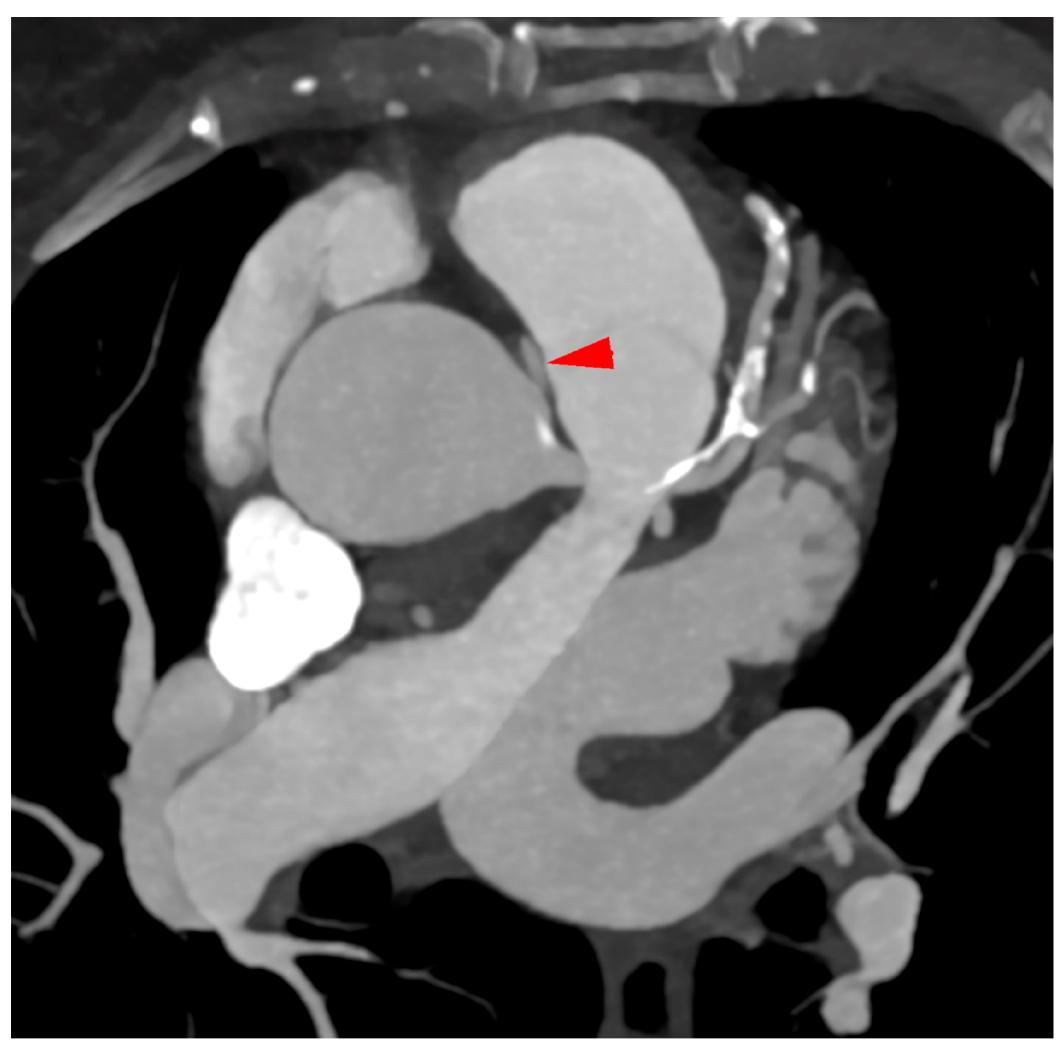
Figure 5. The ostium of the right coronary artery. In the computed tomography image in the VRT reconstruction, in the anterolateral view (Figure 6), the right coronary artery (green line) was visualized with the ostium from the left sinus of Valsalva, and the course of the proximal segment between the pulmonary trunk (blue star) and the aorta (red star).